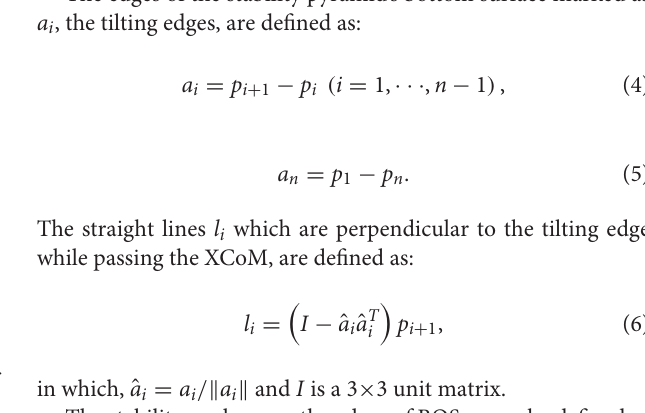
according to Equation